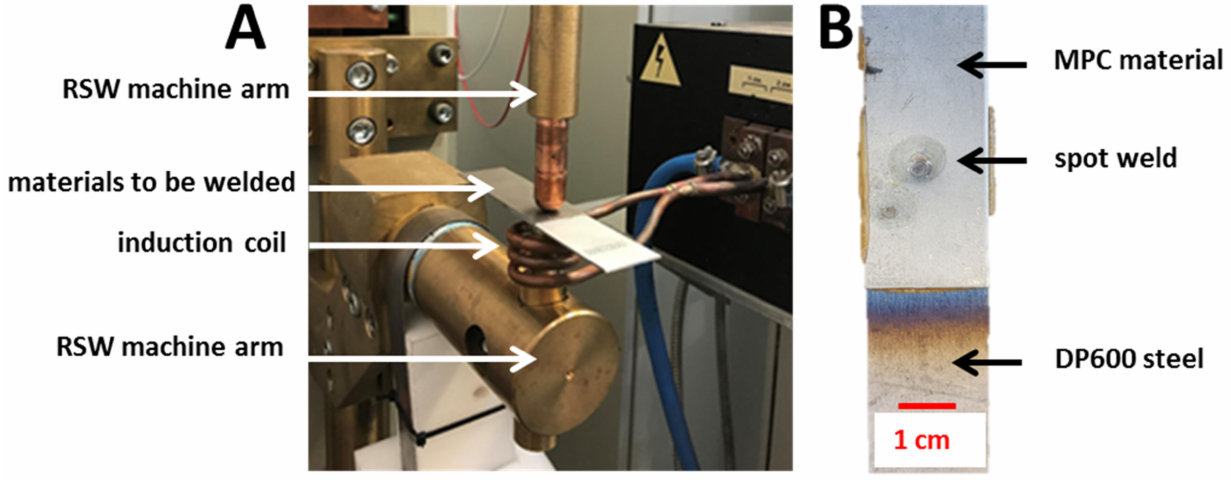
Figure 9. The presentation of: ( A ) sample during induction heating-assisted RSW and ( B ) typical test sample, as welded.